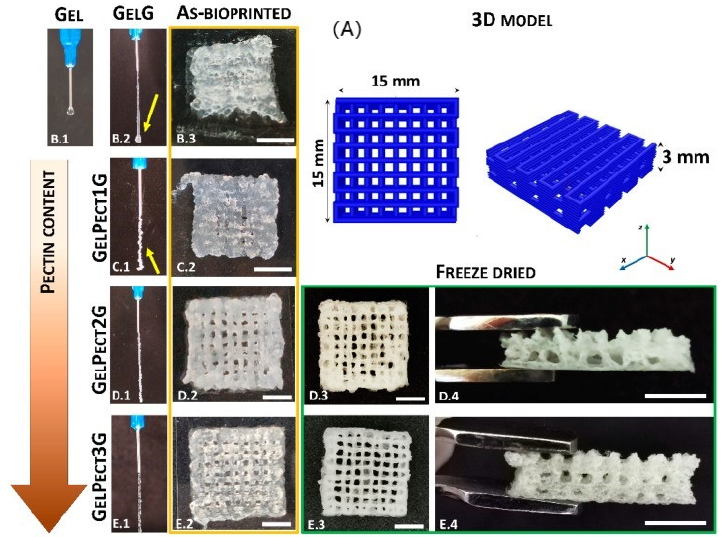
Figure 4. Patch biofabrication: from 3D model to production. ( A ) Illustration of the 3D model of a woodpile scaffold. Extrusion of various gelatin-based bio-ink: ( B.1 ) gelatin (GEL) without crosslinking agent; ( B.2 ) gelatin (GELG) with crosslinking agent GELG; ( C.1 ) bio-ink gelatin-pectin (5–0.5%) (GELPect1G); ( D.1 ) bio-ink gelatin-pectin (0.1–1%) (GELPect2G); ( E.1 ) bio-ink gelatin-pectin (5–2.5%) (GELPect3G). ( B.3 , C.2 , D.2 , E.2 ) Pictures of 3D woodpile structures as bioprinted and ( D.3 , D.4 , E.3 , E.4 ) as freeze-dried (scale bars = 5 mm). Reproduced with permission [120].